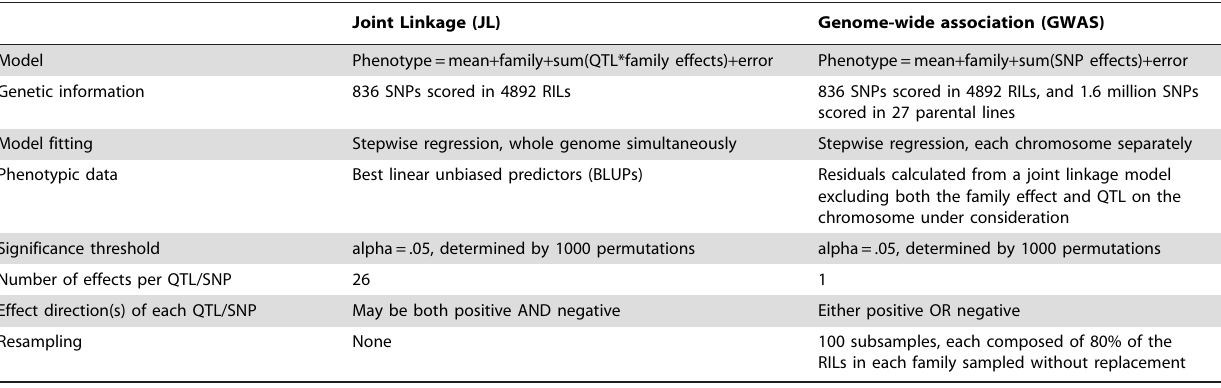
Table 2. Comparison of the two methods used for genetic